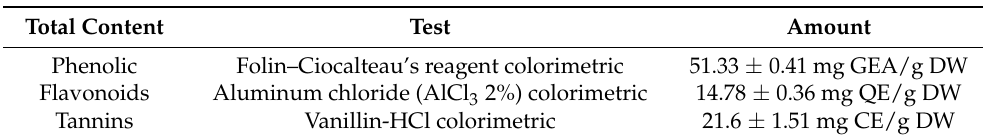
Table 2. The results of measurement of the secondary metabolites contents of Z. spina-christi methano- lic